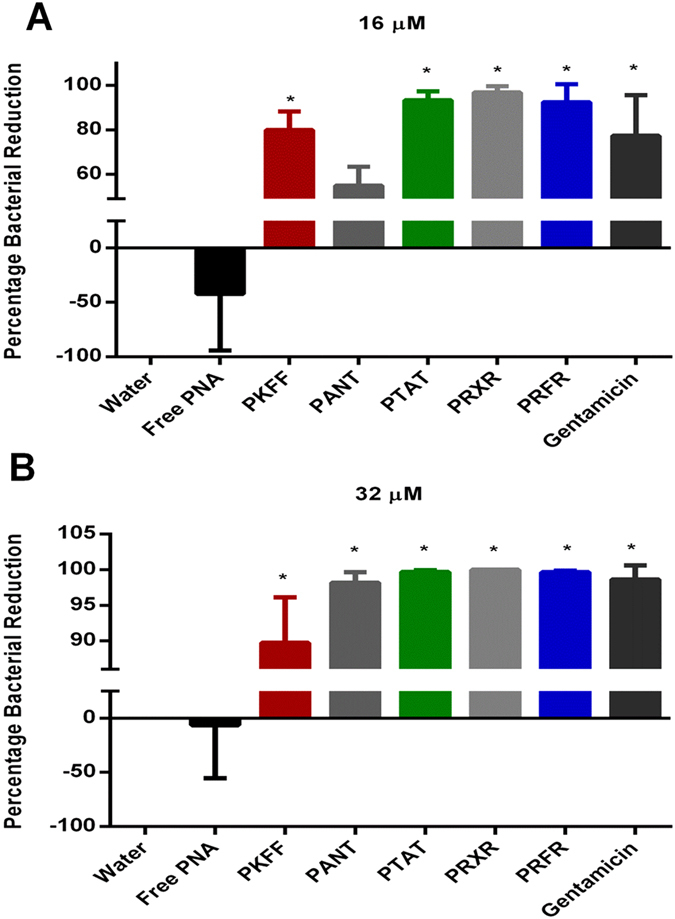
Evaluation of antimicrobial efficacy of PNAs in C. elegans model at 16 μM (A) and 32 μM (B). L. monocytogenes J0161 infected L4-stage worms were treated with PNAs and antibiotic for 18 h. Worms were lysed and the CFUs were counted and the percent bacterial reduction per worm in treated groups were calculated in relative to the untreated control groups. 10 worms in triplicates were used for each treatment. The results are presented as means ± SD from two independent experiments. Data without error bars indicate that the SD is too small to be seen. P values of (*≤ 0.05) are considered as significant.